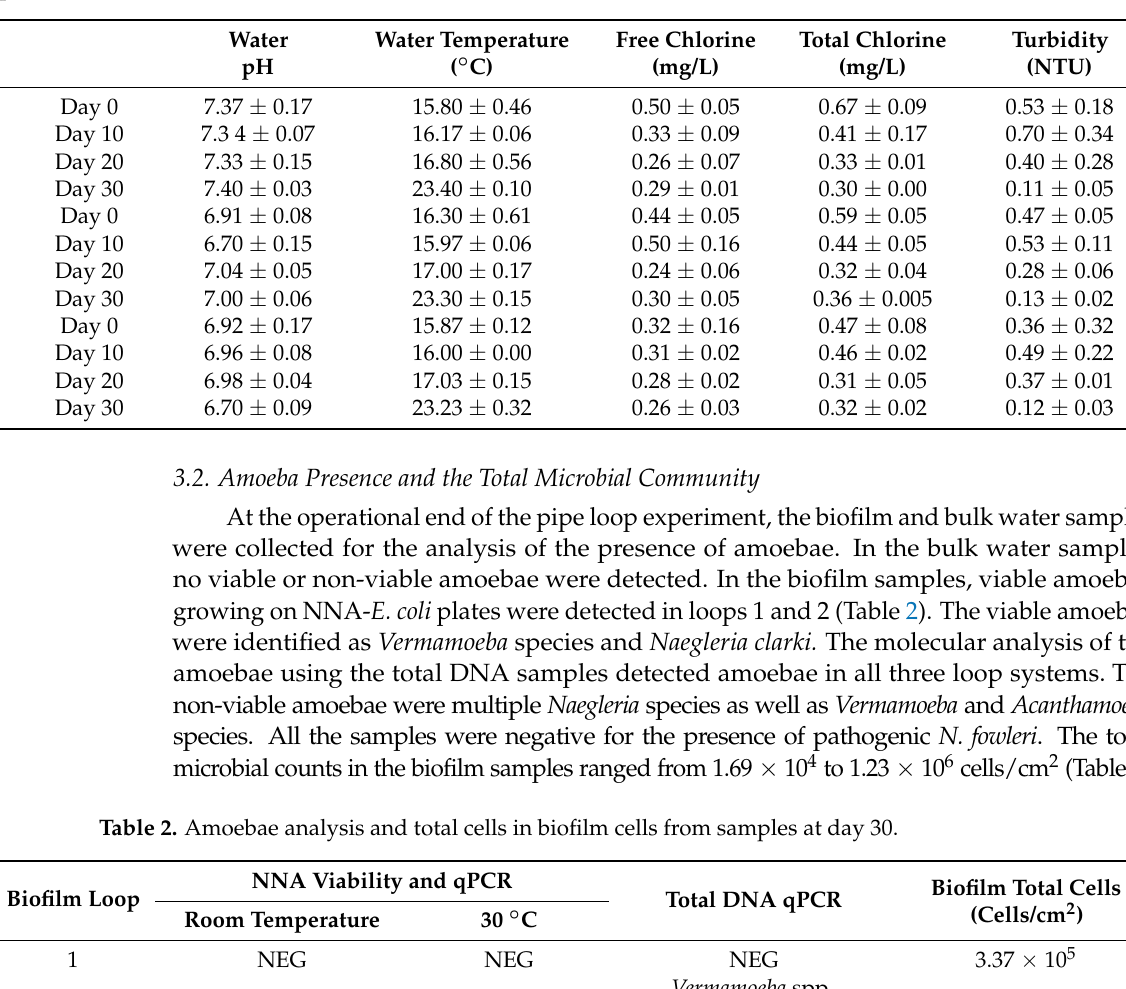
Table 1. Water physico-chemical parameters measured during the experiment. All values represent an average of 3 discrete water samples ± standard deviation.